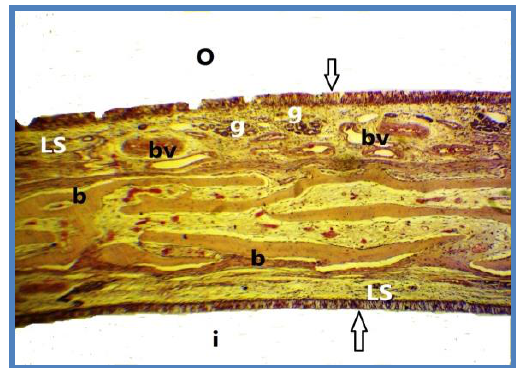
Figure (6): Histological section of nasal cavity (vestibule) showing: -respiratory epithelium(arrows) ,LS- lamina propriasubmucosa , BV-blood vessls ,G- glands, b- bone plate, o- outer surface, i- inner surface.(H&EX40)